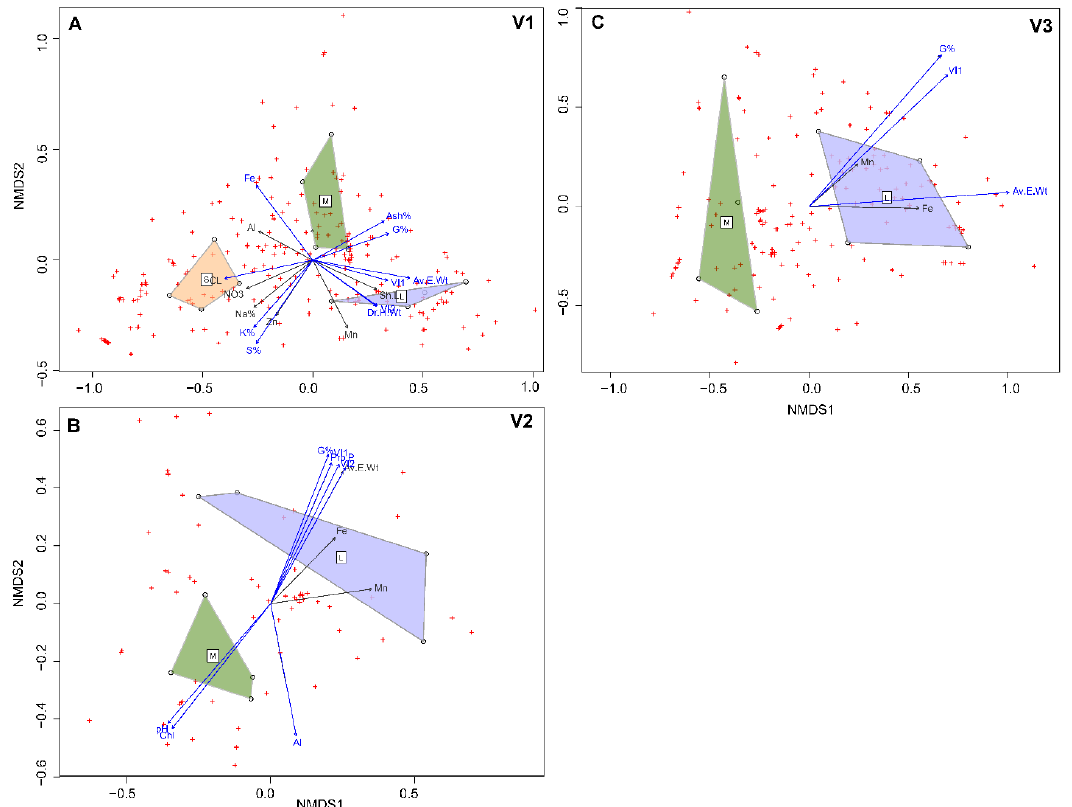
Figure 7. NMDS scatterplot showing significant seedling biometrics, kernel chemistry, and TRFLP profiles of different seed sizes among 3 hybrids: ( A ) Variety 1 (V1), ( B ) Variety 2 (V2), and ( C ) Variety 3 (V3 ). Individual TRFs are shown with red “+” symbols, vectors represent significant plant biometric or kernel chemical parameters; blue vectors are significant to the NMDS ordination and the stress values are <0.2 for each plot.